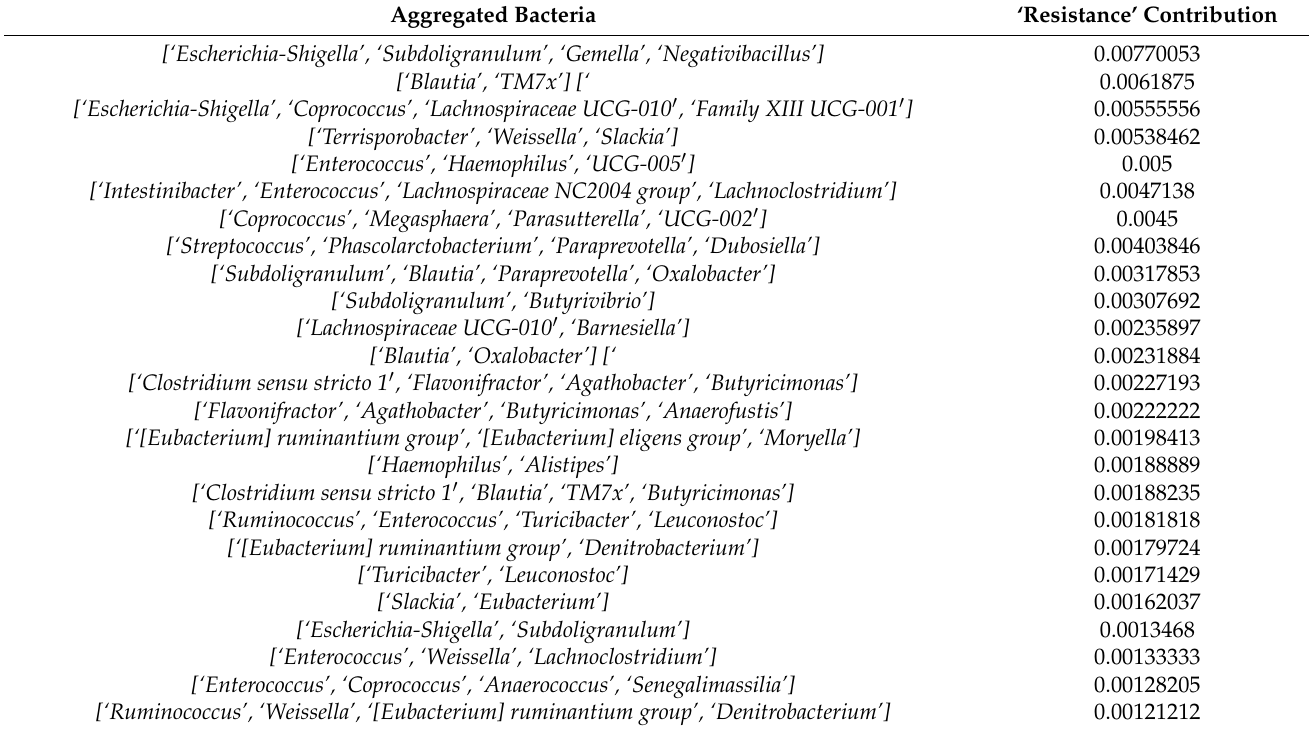
Table 4. Aggregated bacteria significance contributions to the resistant